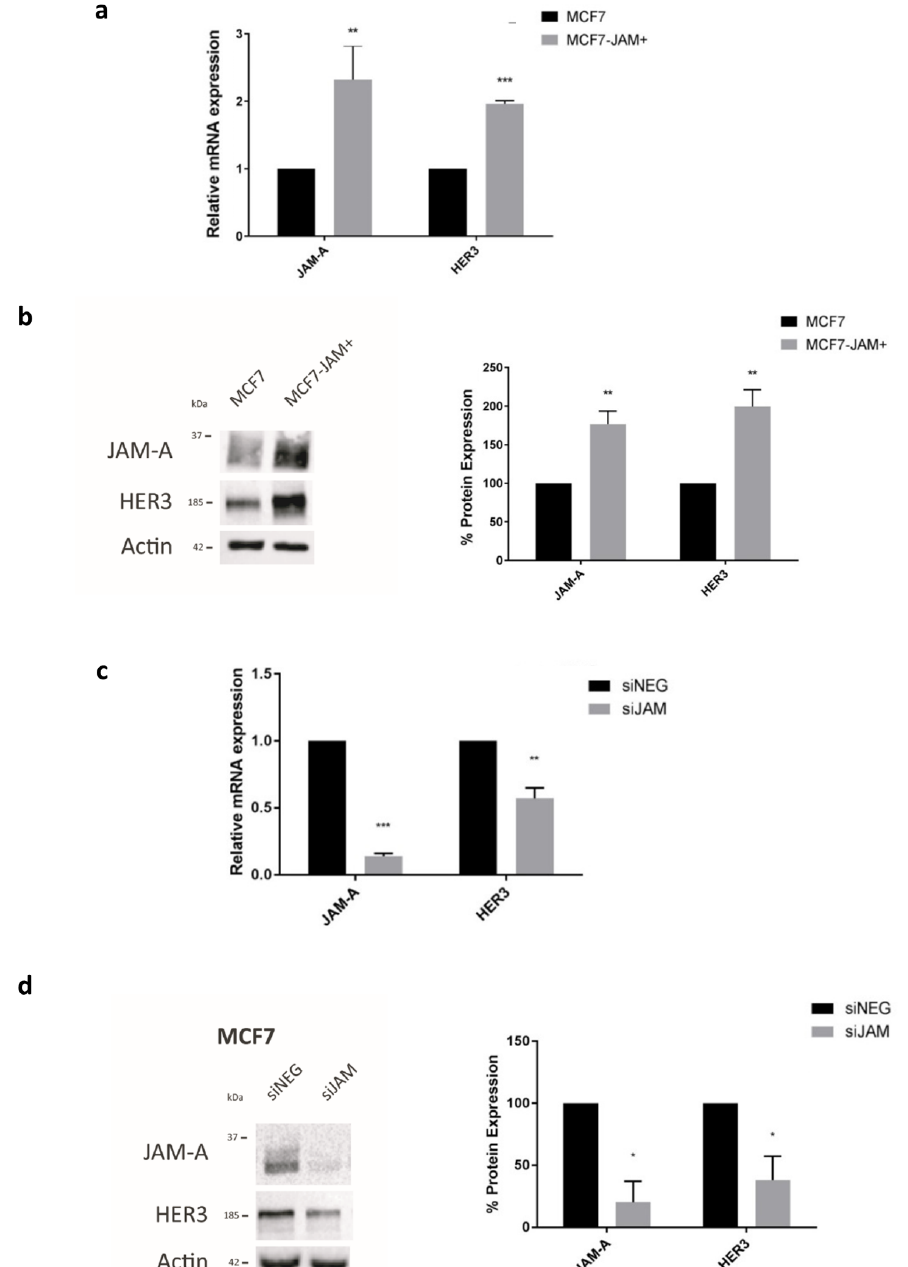
Figure 1. JAM-A levels influence mRNA and protein expression of HER3. RNA and protein from control MCF7 cells overexpressing empty vector (MCF7) and MCF7 cells overexpressing JAM-A (MCF7-JAM+), or MCF7 cells transfected with 25 nM control siRNA (siNEG) or a pool of JAM-A siRNA for 72 h were analyzed by qRT-PCR and immunoblotting. ( a ) Analysis of MCF7-JAM+ by RT-qPCR revealed significant upregulation of HER3 mRNA expression compared to that in wild type MCF7 cells. ( b ) Representative western blot image and densitometric analysis of JAM-A and HER3 normalized to actin revealed that overexpression of JAM-A in MCF7-JAM+ cells was associated with upregulation of HER3 protein expression compared to wild type MCF7 cells. ( c ) RT-qPCR revealed HER3 mRNA expression is significantly reduced after JAM-A knockdown compared to control conditions in MCF7 cells. ( d ) Representative western blot image and densitometric analysis of JAM-A and HER3 normalized to actin revealed that JAM-A gene silencing reduced HER3 protein expression compared to siNEG controls in MCF7 cells. Experiments were performed three times and data represent mean ± s.e.m, compared using two-tailed, equal variance Student’s t -tests, * p < 0,05, ** p < 0.01, *** p <